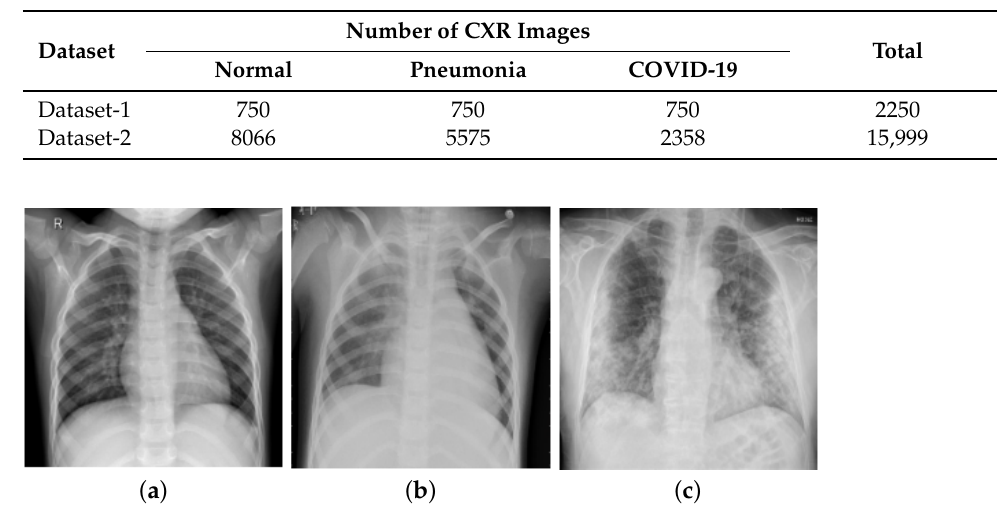
Table 1. Description of the datasets.